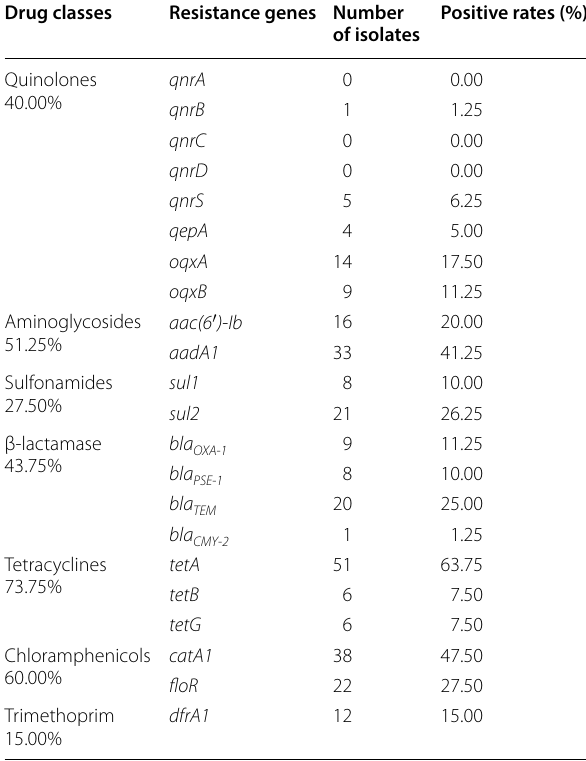
Table 6 Antimicrobial resistance genes of the Salmonella isolates Drug classes